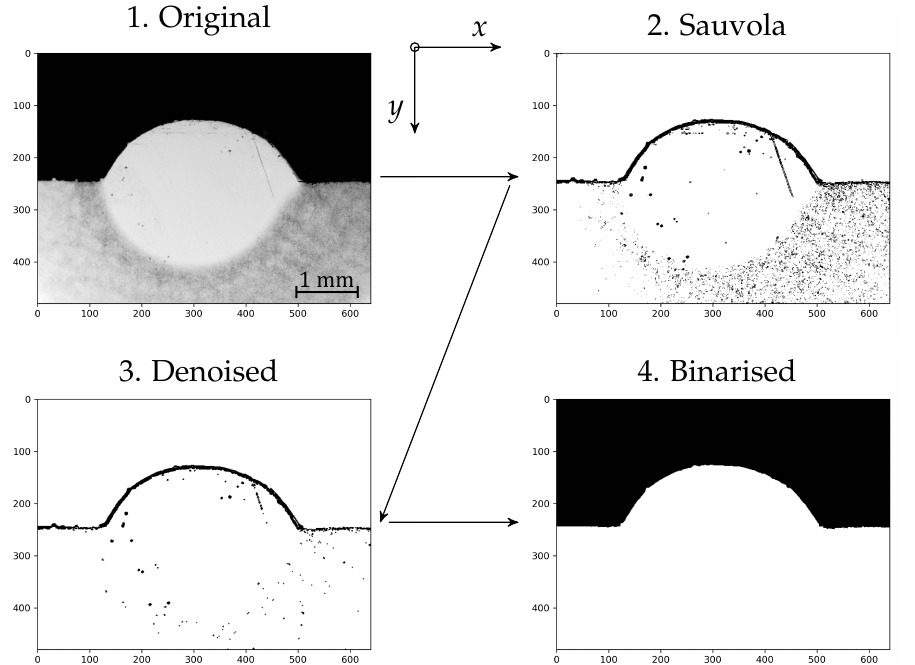
Figure 4. Stages associated with the binarisation of the line bead and the substrate (line bead displayed equates to Track 1). Step 1 is the original image; Step 2 is the result of applying a Sauvola threshold to the original image; Step 3 is the result of denoising the sauvola threshold with a white top-hat filter and a disk structuring element of radius 1 px; Step 4 is the binarised image, in which the background has value of 1 and the foreground has values of 0. The scale in the original image (Step 1) was added in post-processing and was not part of the image during the image processing.